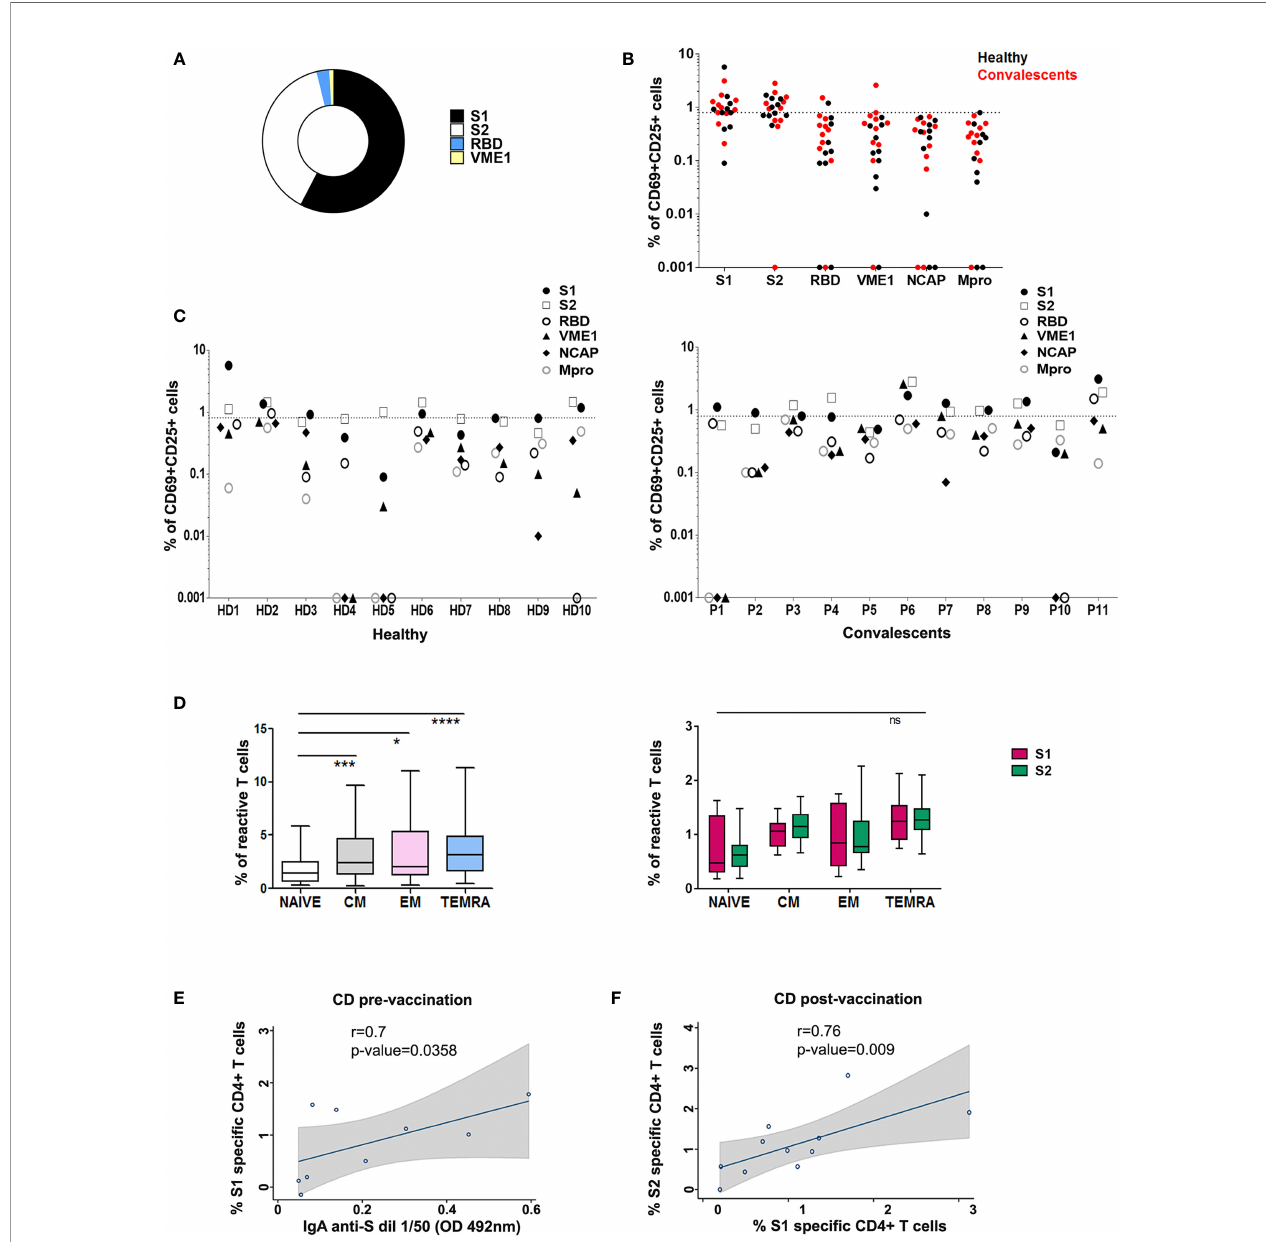
FIGURE 2 | T cell reactivity pro fi le to SARS-CoV-2 in healthy and convalescent individuals after vaccination. (A) Proportion of HD and CD (P) (n=21) with SARS-CoV-2 reactive CD4+ T cells after stimulation with different peptide pools as indicated. (B) Post-vaccination CD4+ T cell activation in HD (black) and CD (red), in the presence of speci fi c peptide pools. (C) CD4+ activity against different peptide pools in each HD (left) and CD (P; right). T cell activity was measured as speci fi c percentage, considered positive when ≥ 0.85% (dotted line). (D) Left , CD4+ T memory subsets speci fi c for SARS-CoV-2 peptide pools in vaccinated donors. *p < 0.05; ***p < 0.001; ****p < 0.0001; Right , Comparison of CD4+ T memory subsets speci fi c for S1 and S2 peptide pools in vaccinated donors; ns, non-signi fi cant. (E) Correlation between SARS-CoV-2 S1 speci fi c CD4+ T cells (%) and IgA anti-S in CD pre-vaccination. (F) Correlation between SARS-CoV-2 S1 speci fi c CD4+ T cells and SARS-CoV-2 S2 speci fi c CD4+ T cells (%) in CD post-vaccination. Spearman correlations were calculated. Fitted linear prediction and its 95% con fi dence interval (transparent gray shadow) are